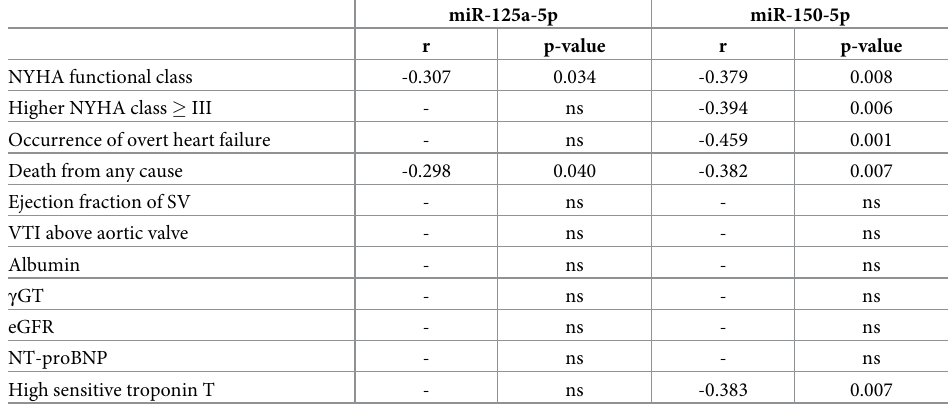
Table 2. Correlation of miRNAs validated by RT-qPCR with clinical, echocardiographic and laboratory parame- ters (n = 48).